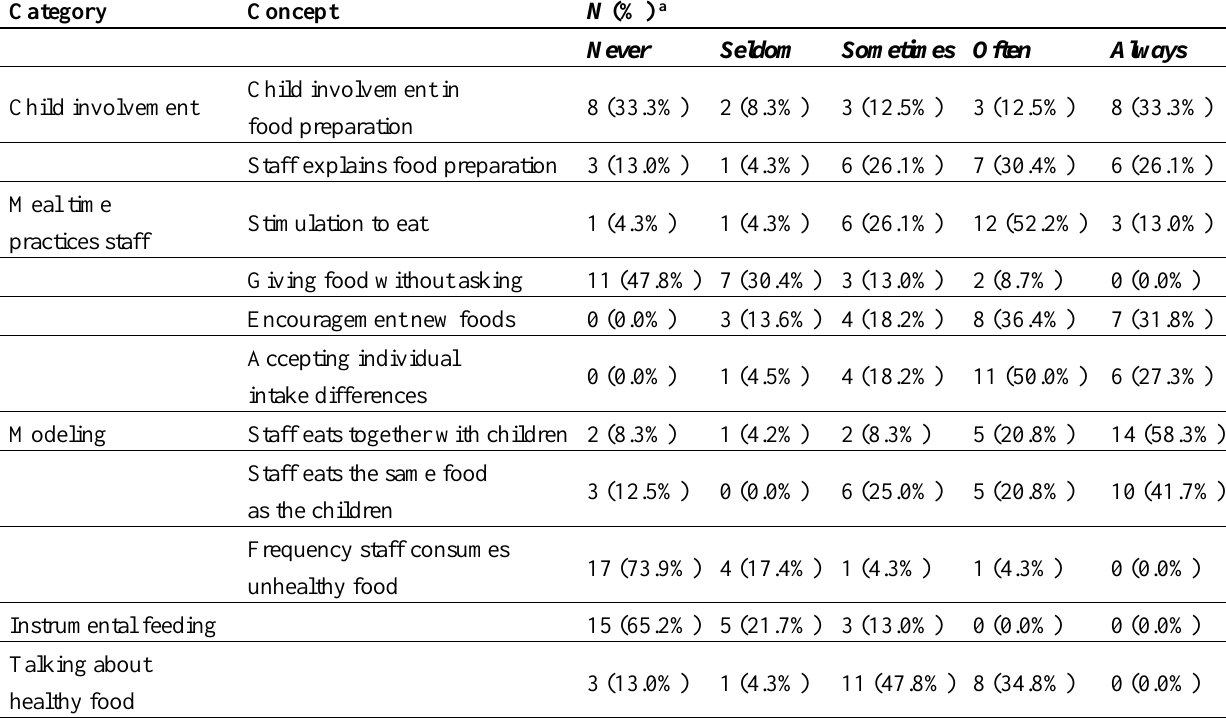
Table 3. Reported use of childcare staff food practices ( N =